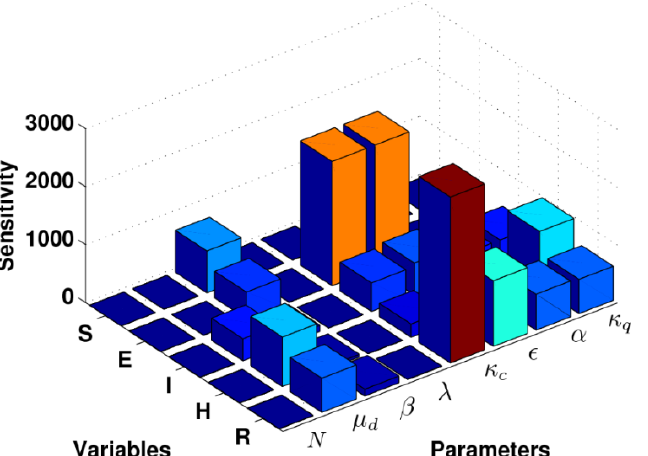
Figure 4. Local sensitivity analysis with non-normalization technique of all variables with respect to all parameters, except b and µ in computational simulations using MATLAB.